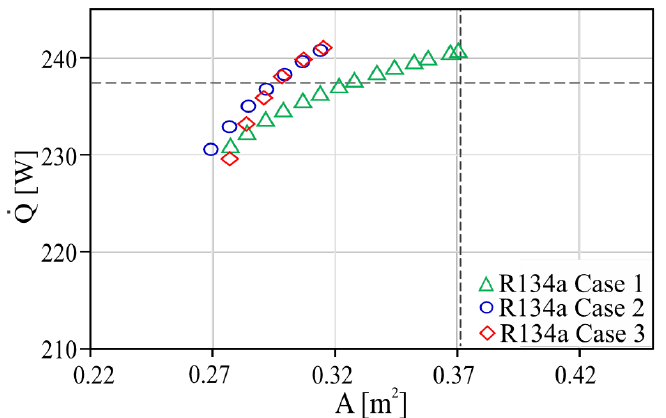
Figure 4. Results of the optimization of the wire-on-tube condenser using R134a.